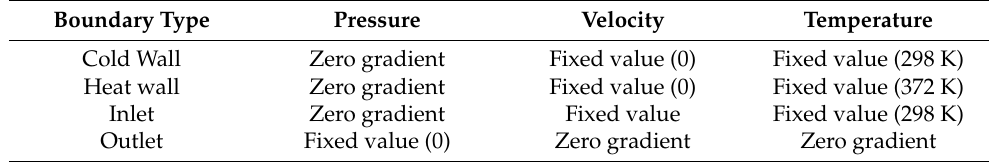
Table 2. Boundary conditions for the numerical simulation. Table 3. Simulation conditions in this study.